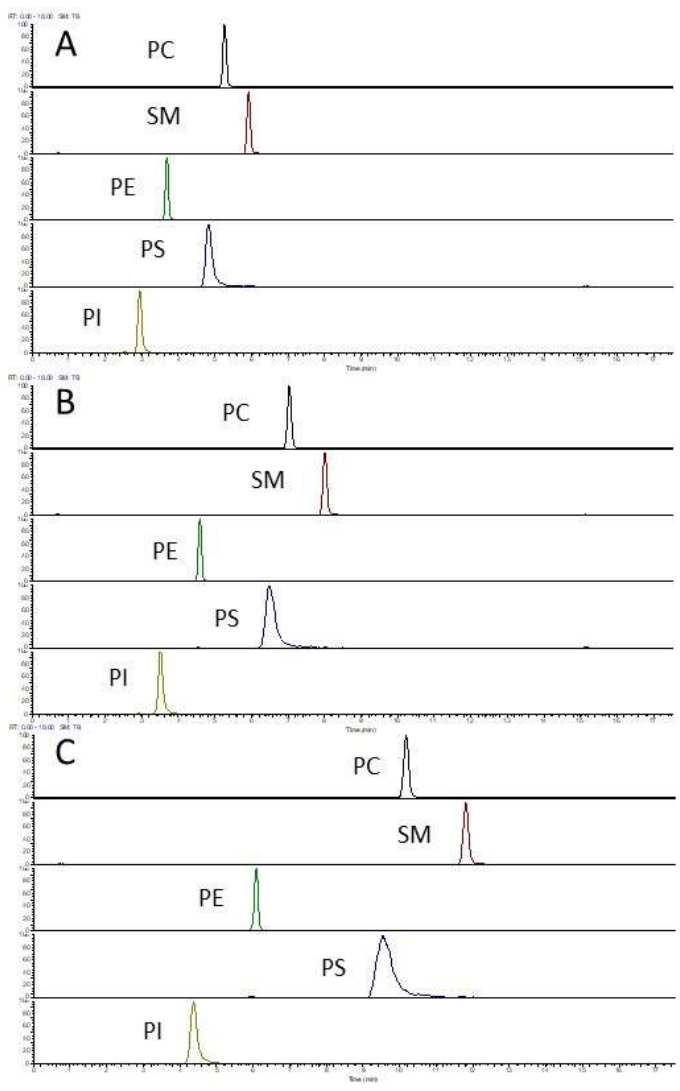
Figure 6. Hilic-MS profile of phospholipid standards. LC separation was by the Kinetex Hilic column using three elution programmes (( A ): Hilic-M4; ( B ): Hilic-M5 and ( C ): Hilic-M6). The standards used were Mouse Splash Lipidomix standards (diluted by 32-fold).